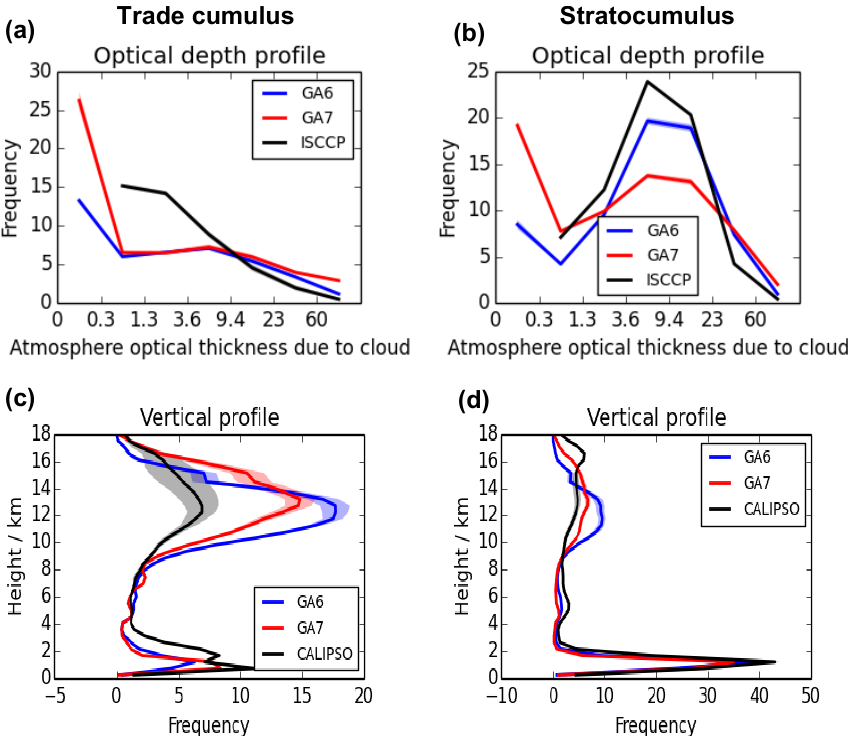
Figure 4. Observed and simulated multi-annual mean ISCCP optical depth frequency histograms (a, b) and CALIPSO height–frequency histograms (c, d) for a trade cumulus region (130–160 ◦ W, 0–20 ◦ S, a, c ) and stratocumulus region (80–90 ◦ W, 0–20 ◦ S, b, d ). Shading around the line plots has been added to reflect significance bounds; however, this is sometimes less than the thickness of the plotted